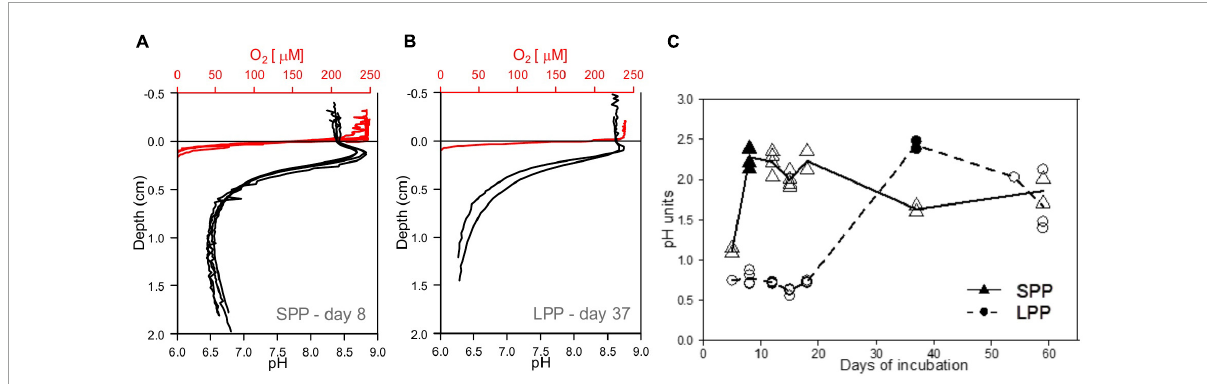
FIGURE3 Development of e-SOx in lab incubations with fish farm sediments. (A,B) Microsensor profiles showing the presence of e-SOx geochemical fingerprint in incubated cage sediment from both short (SPP) and long production period (LPP). Red, oxygen; black, pH, sulfide not detected. (C) Plot of the change in (cid:49) pH in time, with maximum (cid:49) pH obtained at day 8 for sediment from SPP (filled triangle) and day 37 for LPP cage sediments (filled circle). All replicates (points) and average (line) (cid:49) pH are